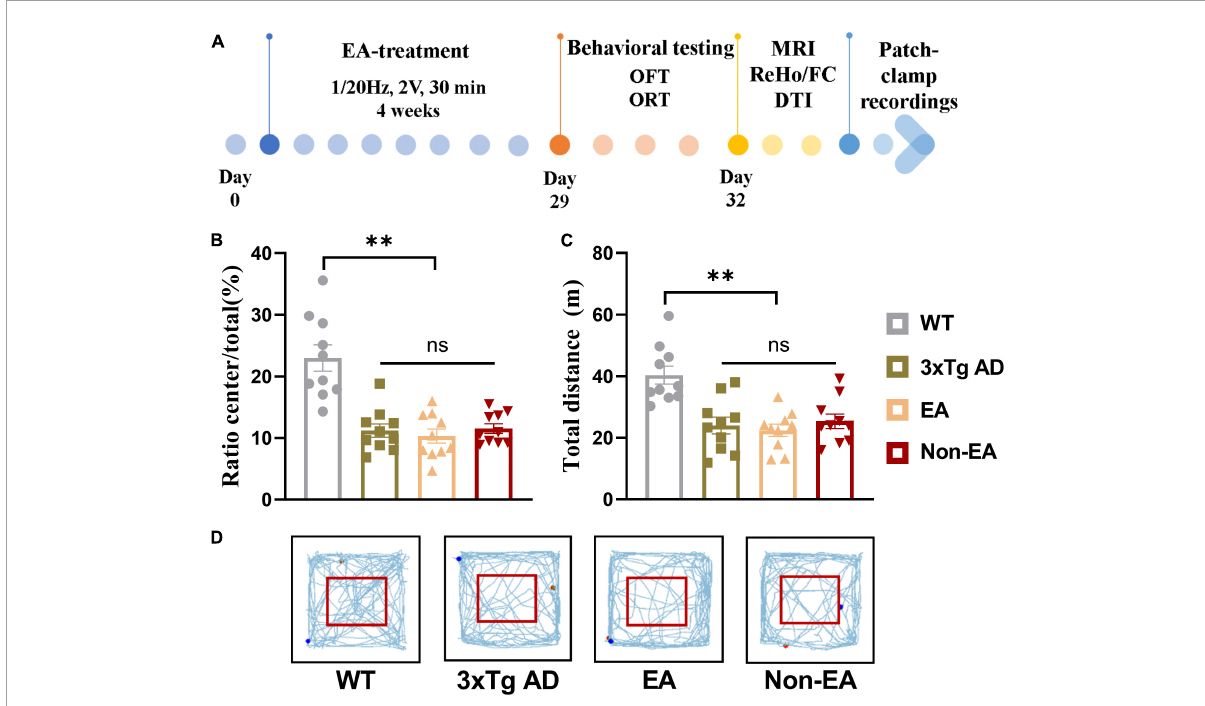
FIGURE1 Effect of EA-treatment on locomotor activity in 3 × Tg AD mice. (A) A schematic of the experimental design. Quantification of behavioral results in open field test ( n = 10 in each group), involving (B) the percentage of time in the central zone, (C) the total distance traveled throughout the field, (D) and the trajectories of mice in the open field. All data represent the mean ± SEM. ** P < 0.01; ns, there was no significant